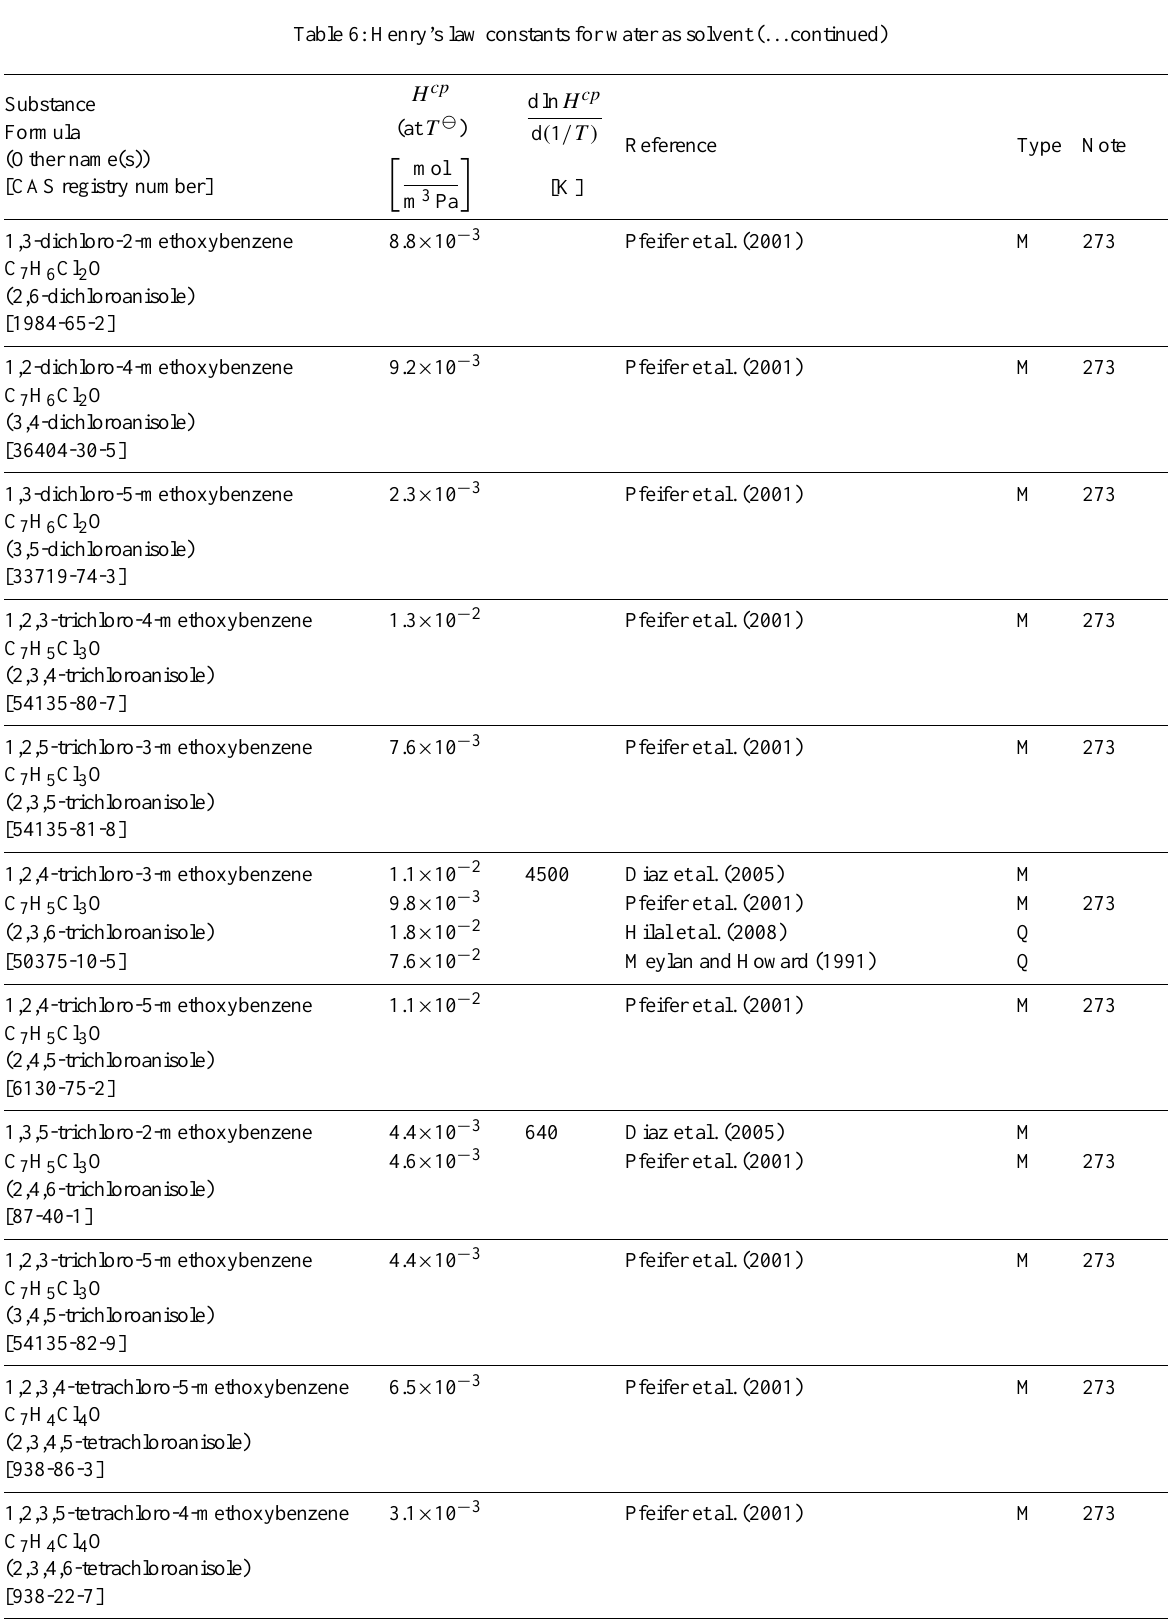
Table 6: Henry’s law constants for water as solvent